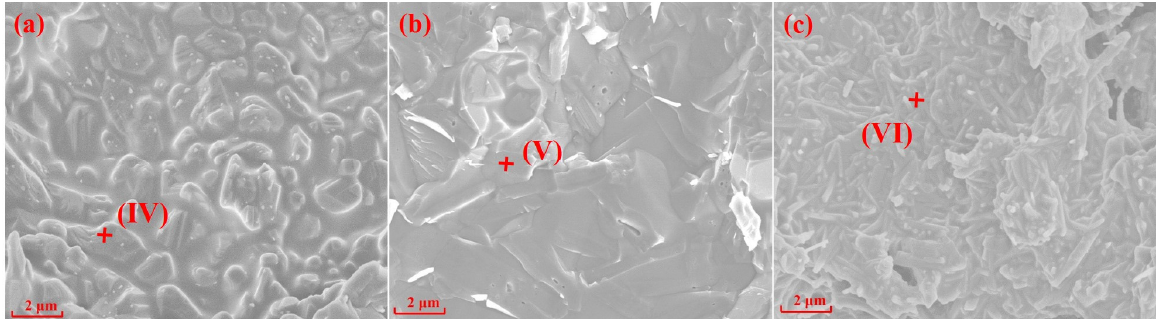
Figure 5. SEM and EDS of specimens with different silicon sources after sintering at 1300 °C: ( a ) Fly ash; ( b ) Silica dust; ( c ) Gangue.